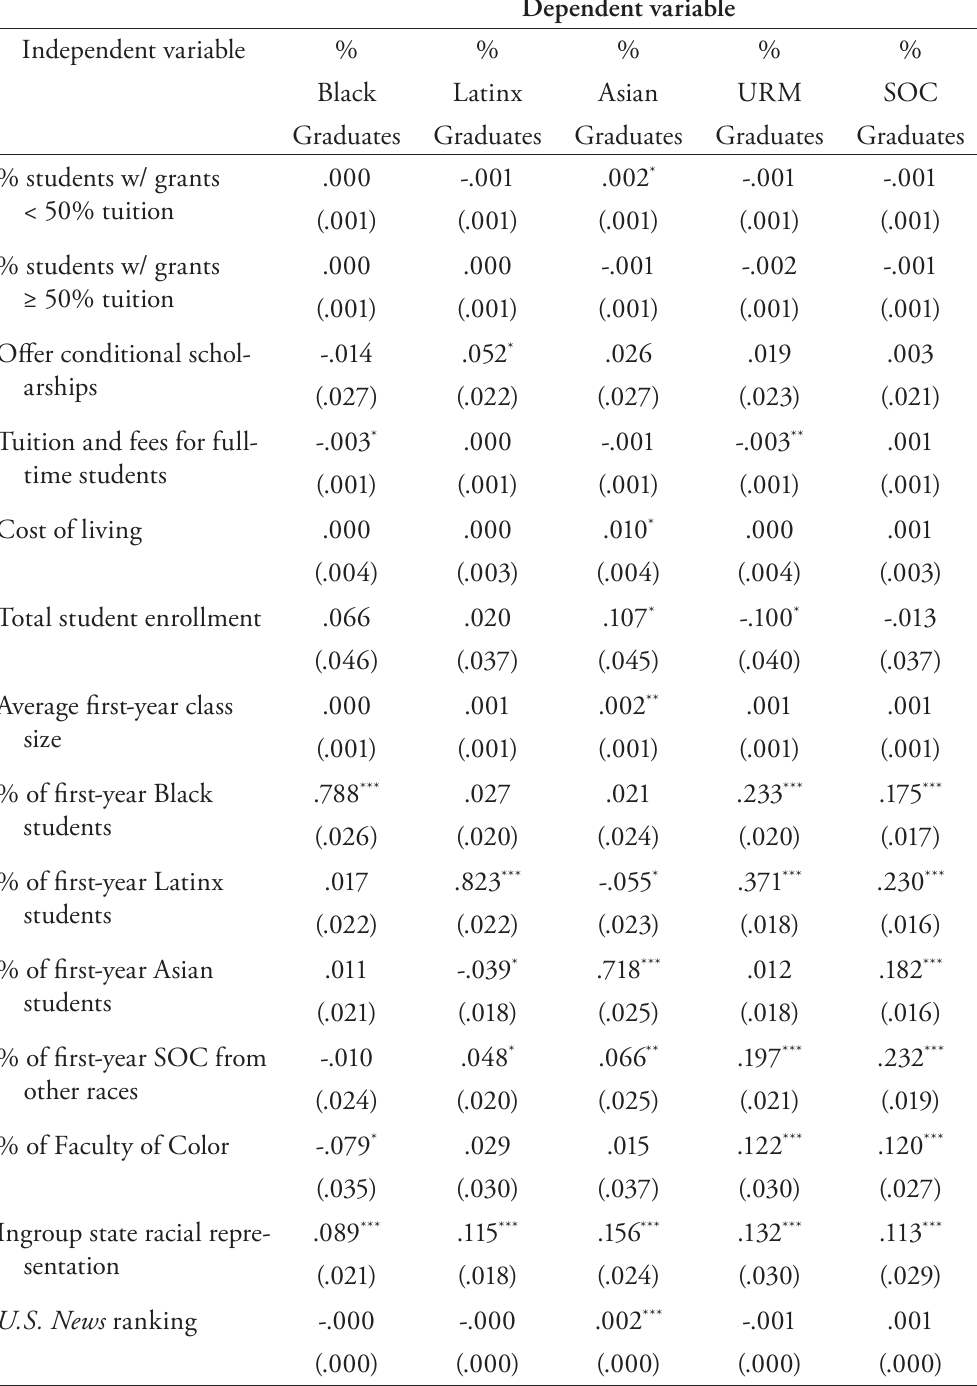
Table 5. Unstandardized Coefficients for Random Effects Analyses